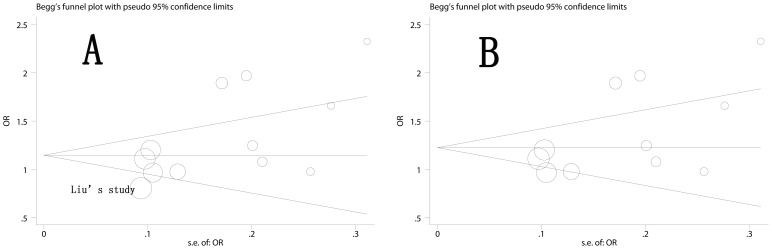
Funnel plot of heterozygote comparison (AG/GG vs. AA).A: funnel plot of all 12 eligible studies, Egger's test p = 0.02; B: funnel plot of 11 studies (Liu's study was excluded), Egger's test p = 0.06; the circles represent the weight of individual study.